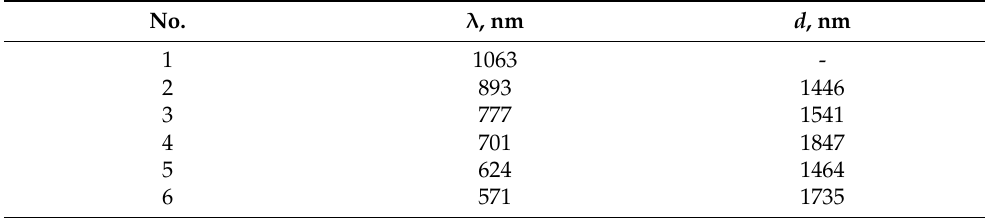
Table 1. The maximum interference pattern λ and the layer thickness d .